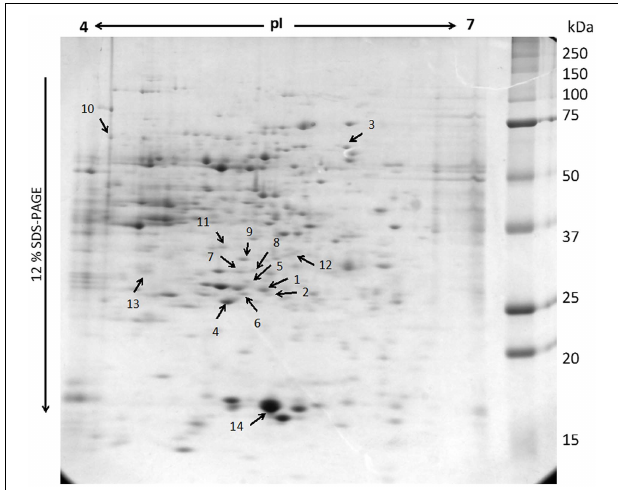
FIGURE 3 | Representation of two-dimensional electrophoresis (2-D SDS-PAGE) profiles of the soluble proteins extracted from Uncaria tomentosa root cultures (250 µ g). The proteins were separated on a pH 4-7 linear IPG strip, followed by 12% SDS-PAGE. The gel was visualized by Sypro Ruby staining. Number indicates the protein spots identified by MS